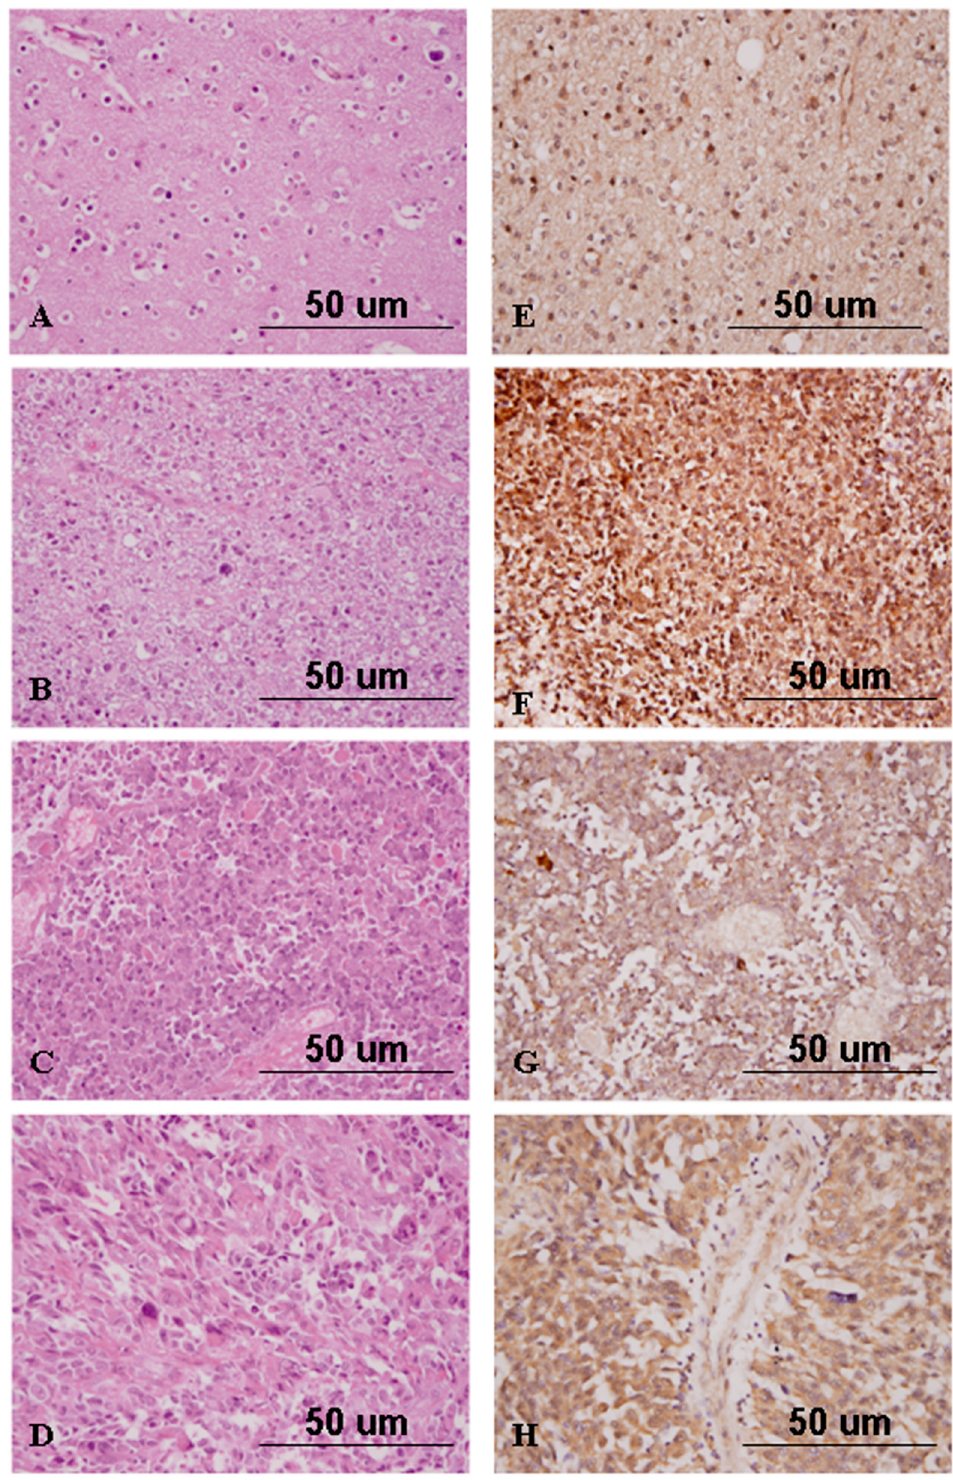
Figure 4. Hematoxylin and eosin staining of oligodendroglioma ( A ); anaplastic oligodendroglioma ( B ); ependymoma ( C ); and anaplastic ependymoma ( D ); and immunohistochemical analysis of Nrf2 in oligodendroglioma ( E ); anaplastic oligodendroglioma ( F ); ependymoma ( G ); and anaplastic ependymoma ( H ) (original magnification ×400).